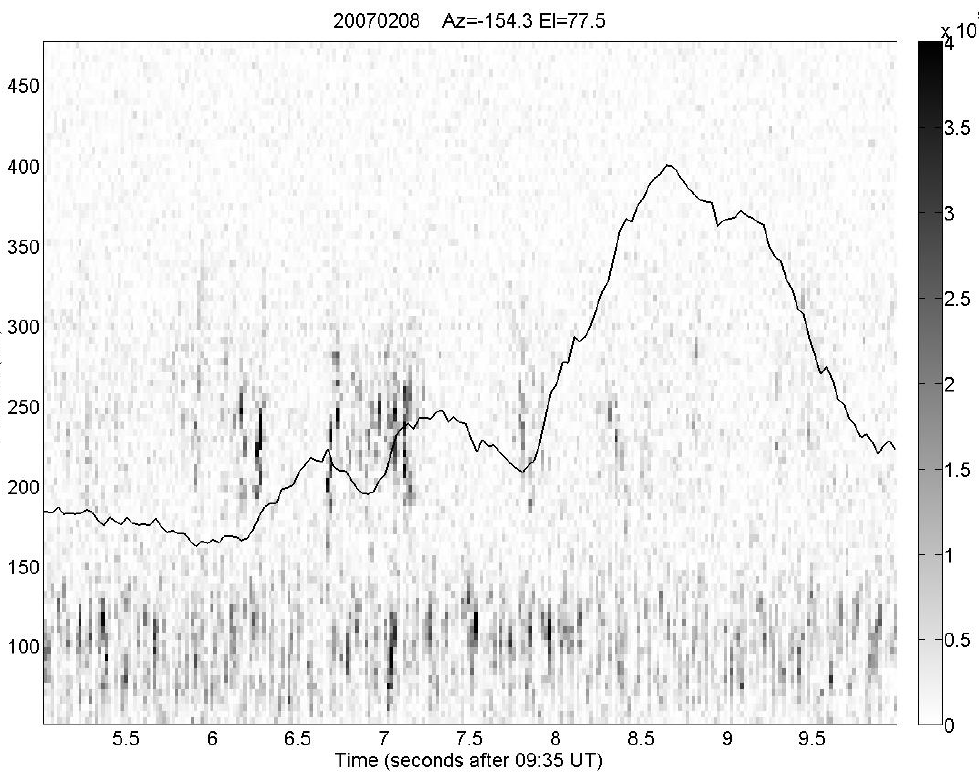
Fig. 3. The returned power from the raw data, in arbitrary units, ( ∼ 19ms resolution), showing that the large returns are coming from very short time intervals within the 15s integration period of the integrated data. The line overplotted shows the relative intensity of the aurora from the region inside the radar beam, taken from the camera data ( ∼ 33ms resolution). The raw power is not corrected for the 1 in power with distance. The returns near 100km altitude are the signal from the incoherent scatter associated with the E-region